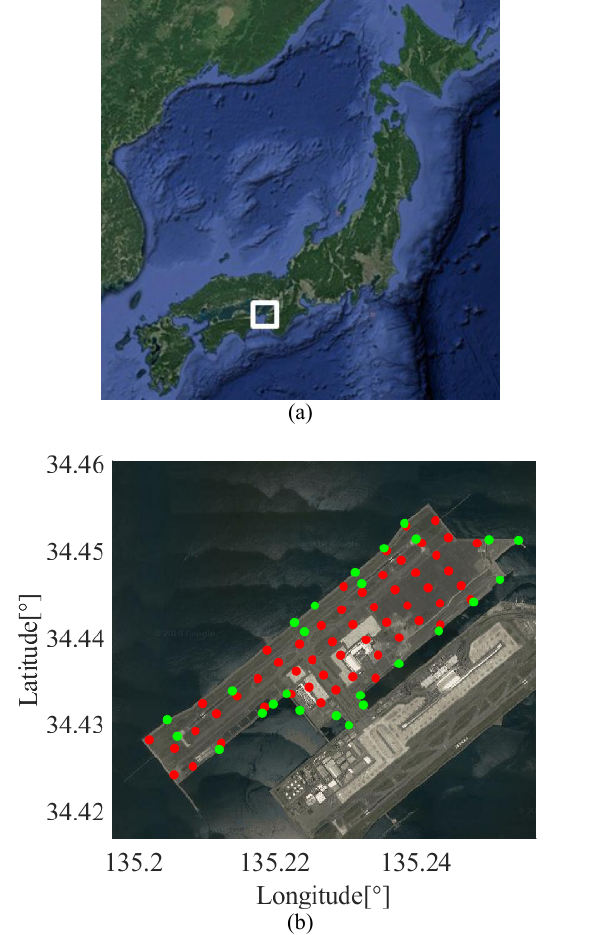
Figure 2. Study area: Kansai International Airport (KIX), Osaka, Japan. (a) The white rectangle represents the location of KIX in Japan. (b) Islands I (lower) and II (upper) of KIX. In (b), the red and green points represent leveling and GPS locations, respectively. The images are from Google Earth. Map data